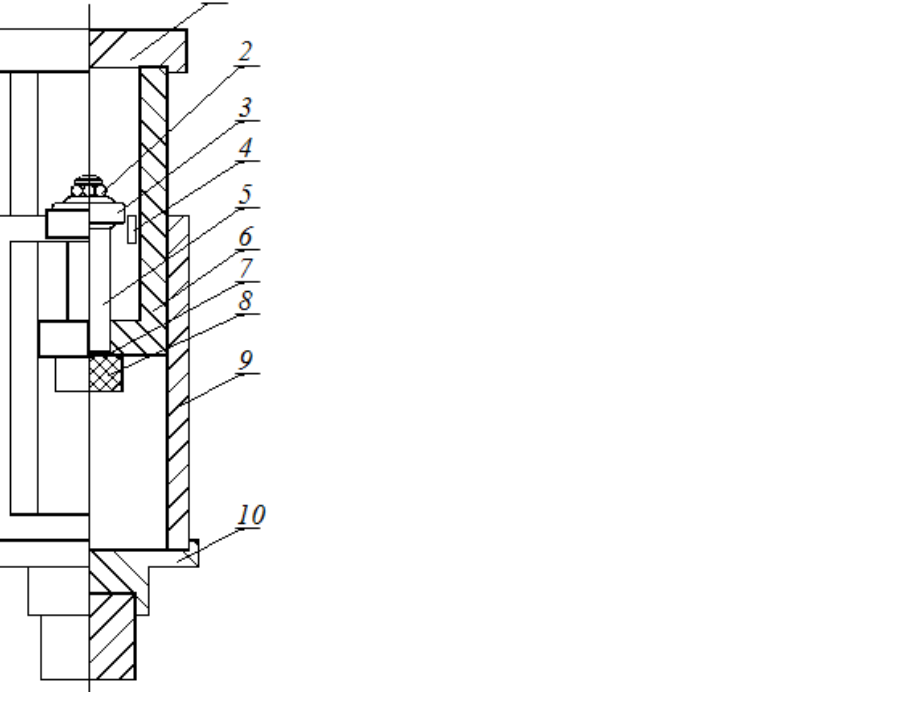
Figure 4. Diagram of the reversing device: 1-support cover; 2-nut; 3-hinge; 4-cover; 5-stock; 6–piston.